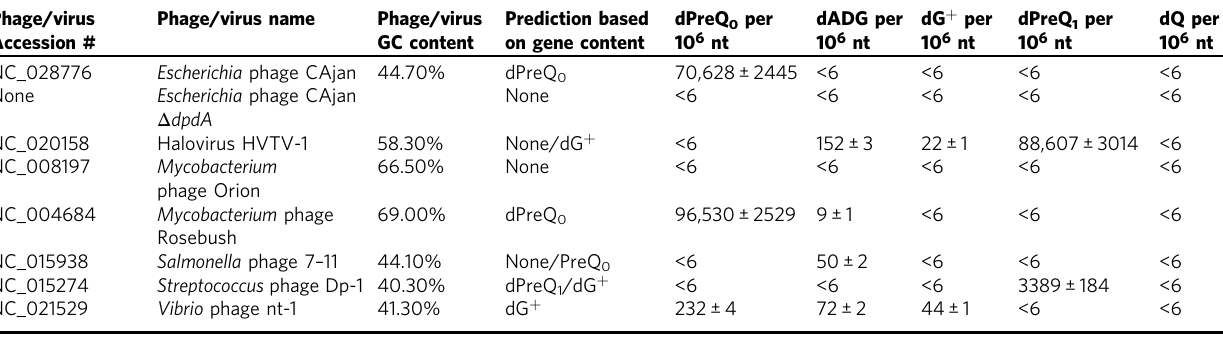
Table 2 DNA modi fi cations identi fi ed by mass spectrometry in the different